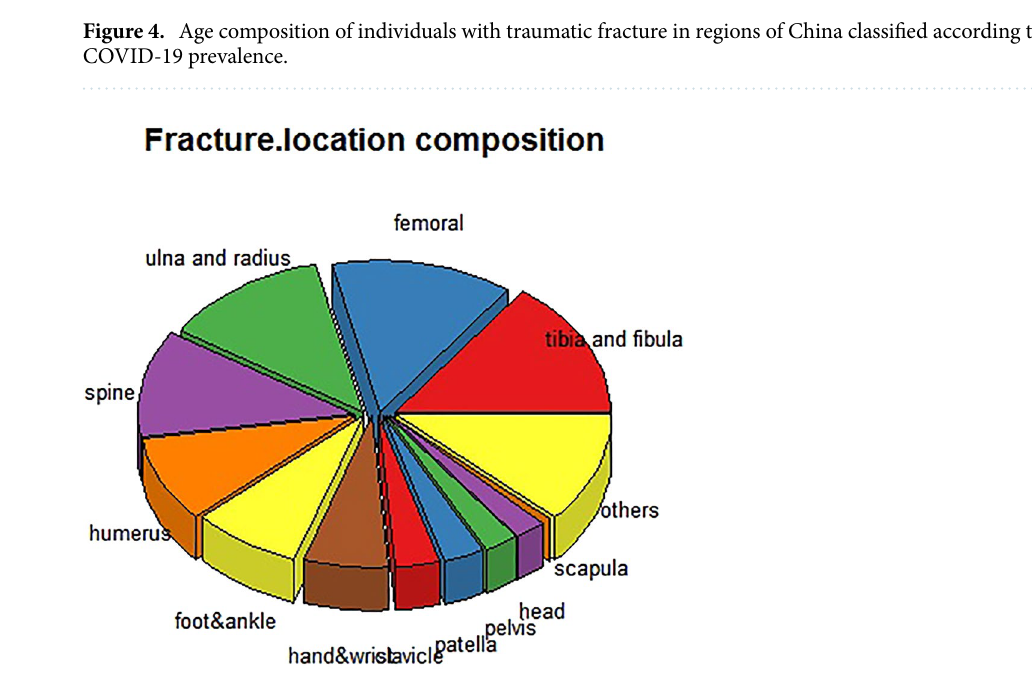
Figure 5. Locations of fractures that occurred during the period of COVID-19 prevalence in China.